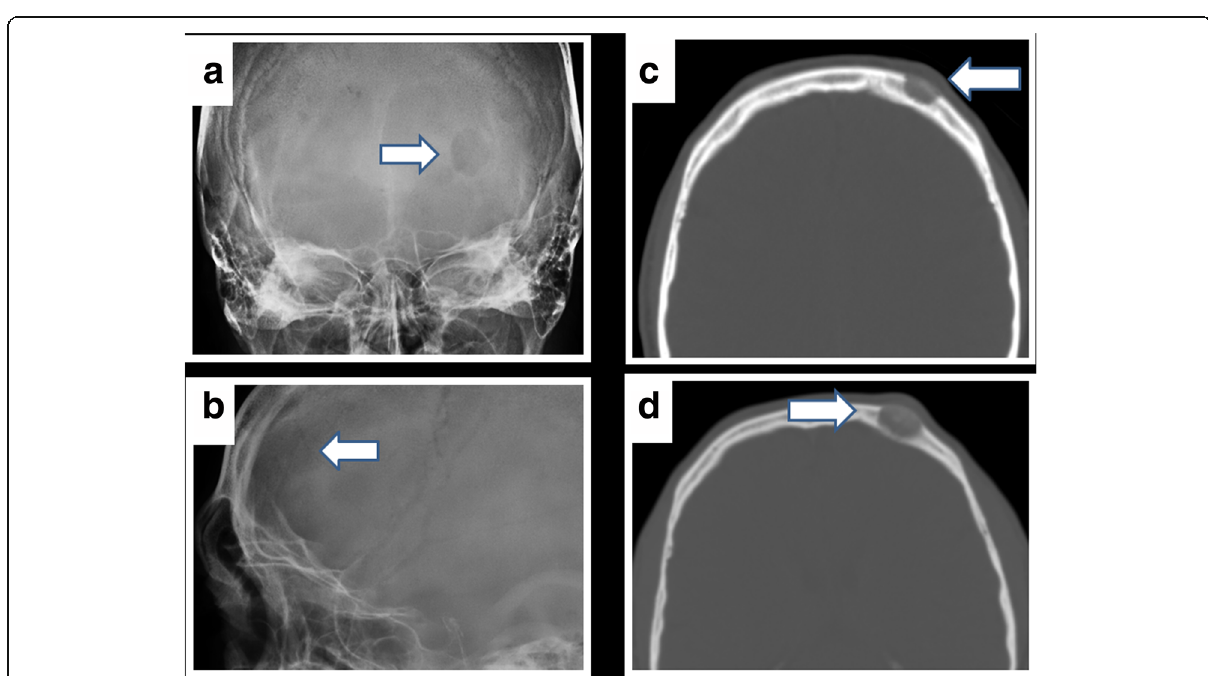
Fig. 1 Radiological images of a left frontal intraosseous lesion. a Simple X-ray of the skull, in the antero-posterior view and b in the lateral view of a radiolucent lesion (white arrows), rounded, with well-defined edges, located in the left frontal bone. c First CT cerebral with bone window performed on the patient 3 years ago. In localization of the left frontal region, a lytic bone lesion is observed that discreetly expands the diploe both in its internal and external table, with well-defined contours in its medullar region, being worse defined there could even be minimal solutions of continuity in the internal table. A poorly defined trabecular bone pattern was observed inside the lesion. The findings are compatible with a moderate aggressiveness. d In the last CT cerebral, it was appreciated how the lesion had increased in size. Produces a slight insufflation of the frontal calotte with loss of the cortex of the external table. Its behavior is of low radiological